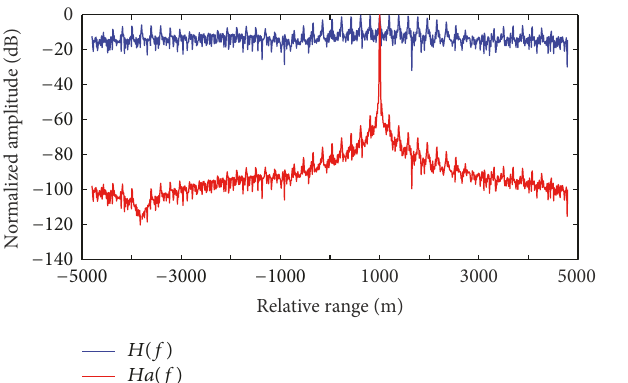
Figure 9: The band-pass filtering function ( 𝑇 𝑠 = 10 𝜇𝑠 ).